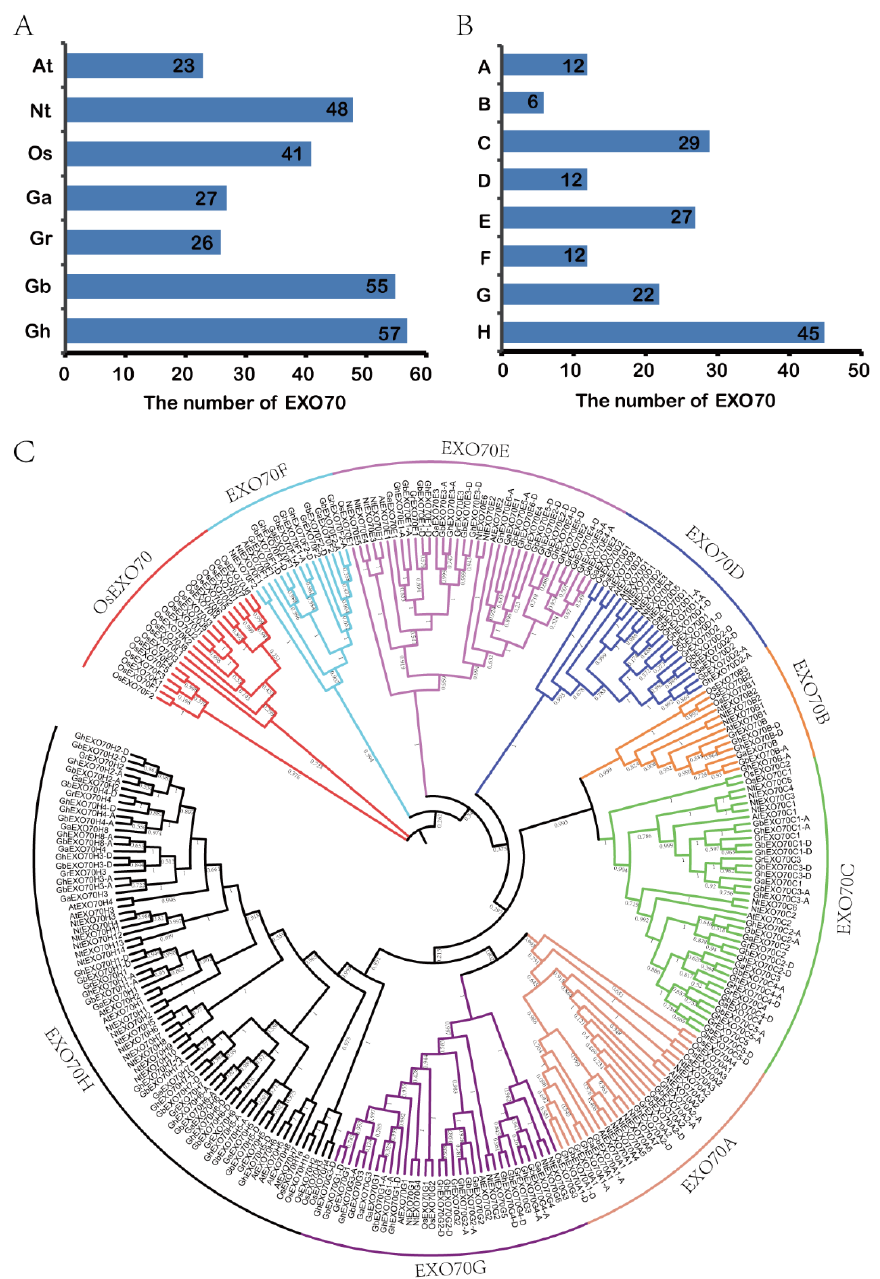
Figure 1. Numbers and phylogenetic relationships of EXO70 family genes in Arabidopsis, rice, upland cotton, sea island cotton, Asian cotton, Raymond cotton, and tobacco. ( A ) Numbers of EXO70 family genes in Arabidopsis, rice, upland cotton, sea island cotton, Asian cotton, Raymond cotton, and tobacco. At: Arabidopsis thaliana ; Nt: Nicotiana tabacum ; Os: Oryza sativa ; Ga: G. arboretum ; Gr: G. raimondii ; Gb: G. barbadense ; Gh: G. hirsutum . ( B ) Quantitative statistics for each subgroup of the EXO70 family genes in upland cotton, sea island cotton, Asian cotton, and Raymond cotton. ( C ) Phylogenetic analysis of EXO70 family genes in Arabidopsis, rice, upland cotton, sea island cotton, Asian cotton, Raymond cotton, and tobacco.